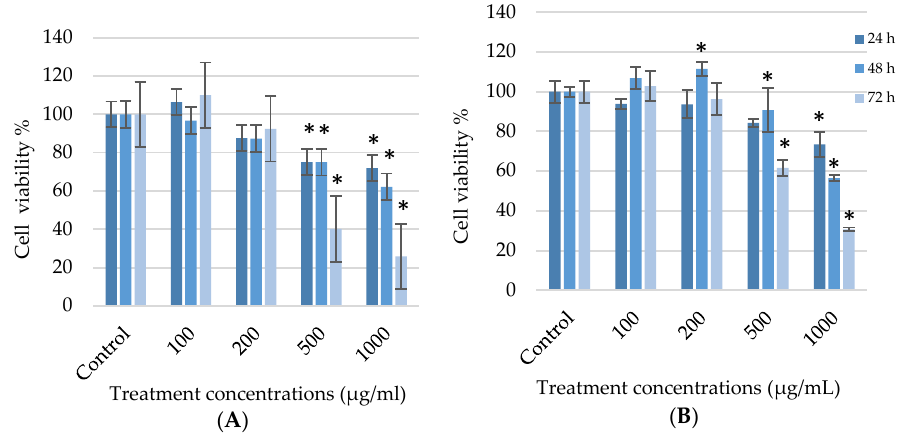
Figure 1. Cell viability of the human melanoma (A375) cells ( A ) and normal human skin (HaCaT) cells ( B ) treated with 100; 200; 500 and 1000 µg/mL of the G. africana ethanolic extract for 24, 48 and 72 h determined using the 3-(4,5-dimethylthiazol-2-yl)-2,5-diphenyltetrazolium bromide (MTT) assay. Data represent the mean ± SD, n = 3, where the * indicates statistical significance at level p < 0.05 vs. the control.